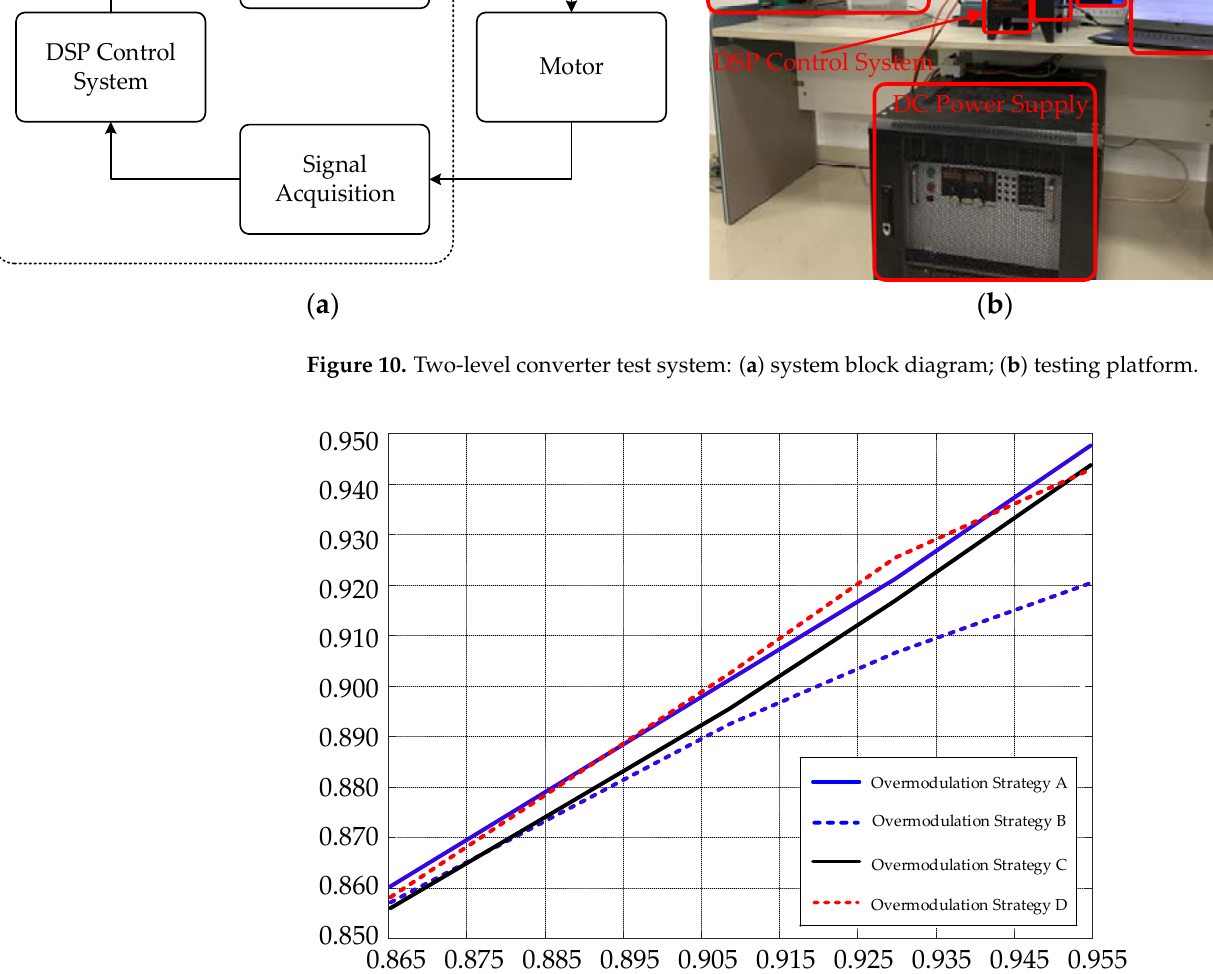
Figure 11. Experimental results of base ‐ wave VTR for each strategy.